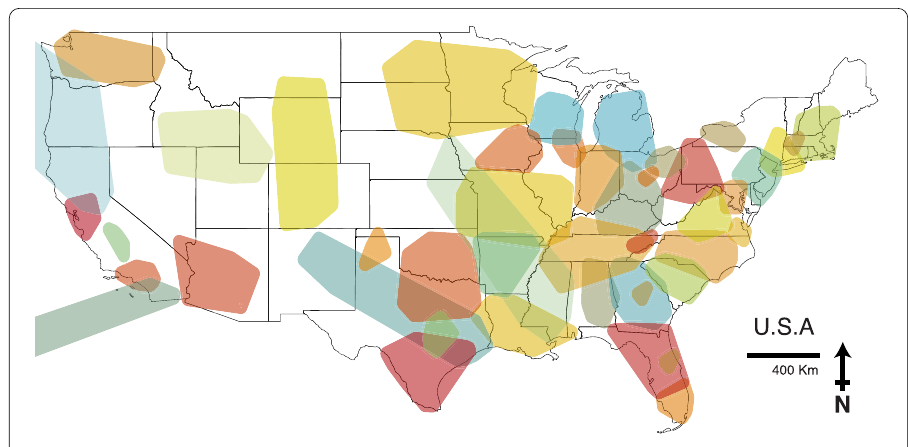
Figure 2 The 2122 hospitals were assigned to 50 statistically determined communities, i.e. a group of hospitals that transfers many more infants amongst each other than with hospitals outside of the “community.” Communities are represented by a minimum spanning polygon around 90% of the infant transfers. The borders have been obscured to protect the privacy of the health care facilities